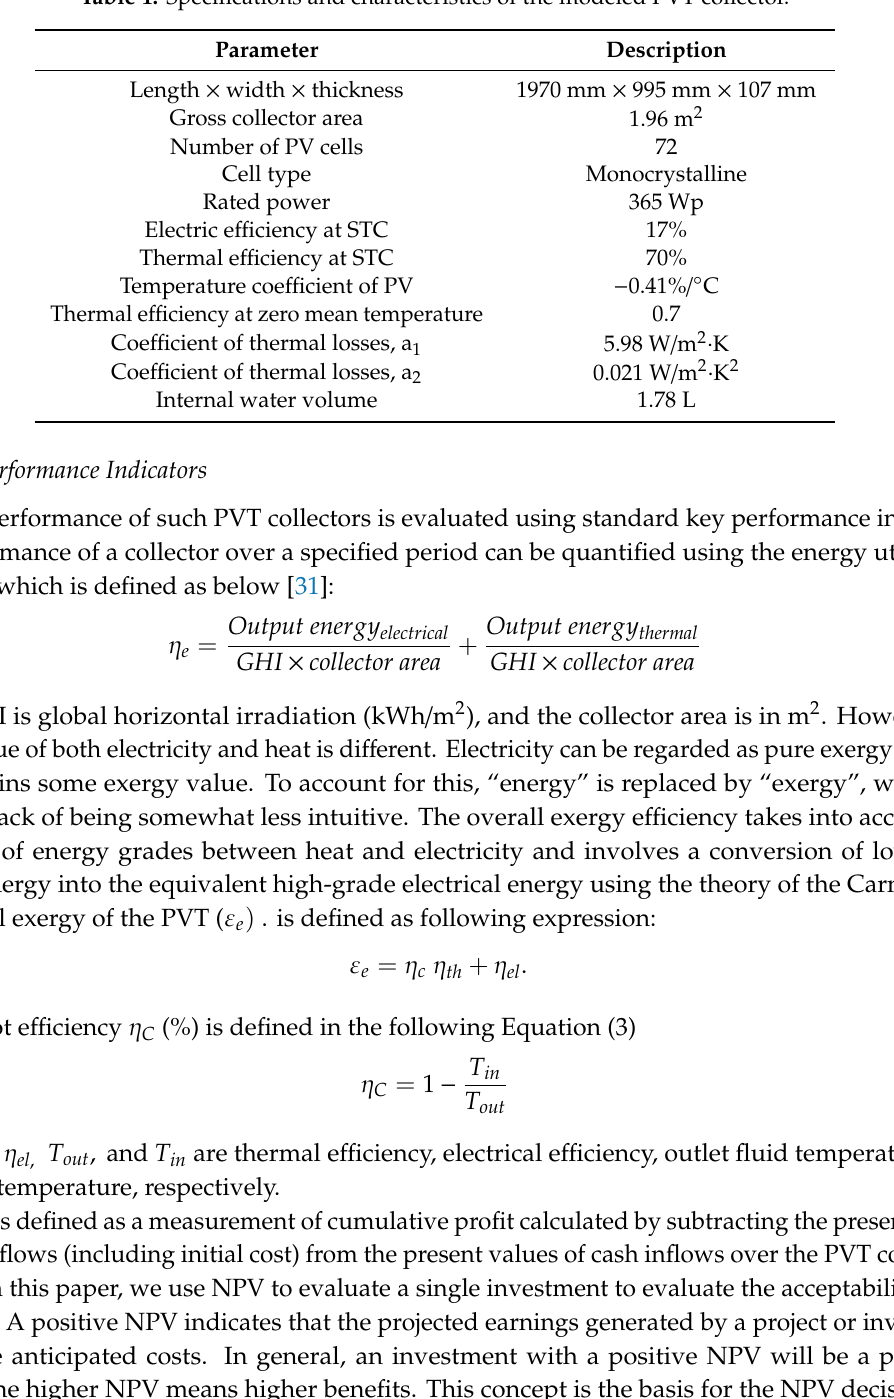
Table 1. Specifications and characteristics of the modeled PVT